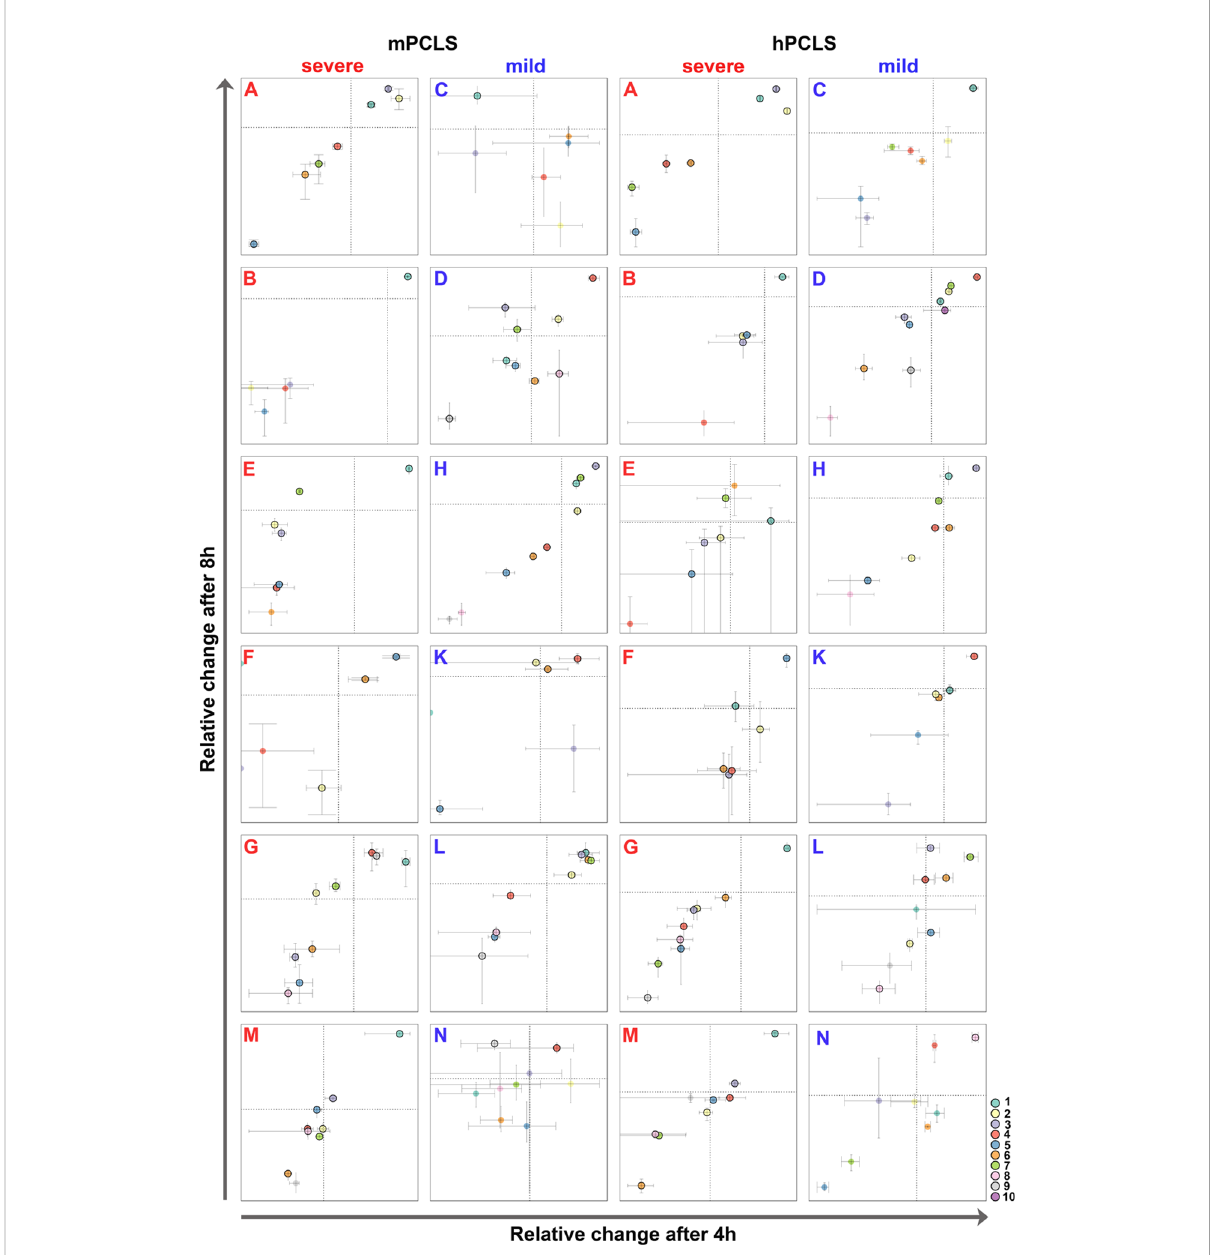
FIGURE 2 Outcomeof competitive fi tness experimentsof 12longitudinal coursesin murine(left)andhumanPCLS(right).Relativegrowthchangesof serial P. aeruginosa isolatesduringcompetitive fi tnessexperimentsarecomparedat 4hand8 h, respectively. Severelongitudinalcoursesarelabeledwithred, mild courseswithblueletters. Eachserialisolateisdifferentiatedbycolorsortedbyincreasingcolonizationtimeof thecloneinthepatient ’ s lungs: P. aeruginosa strainsmarkedwithoutablackouterringwere recovered atsuchlowquantitiesthatthe strain-speci fi cSNPcountswereclassi fi edas ‘ detectable,but not quanti fi able ’ (seeMaterial andmethodssection). Theaxislabelingas well asthescalingandthecolorof theisolatesareexplained inmore detailin Supplementary DatasetS1 showingallplotsathigherresolution.Supplementary FigureS1showstheoutcomeof theotherbiological